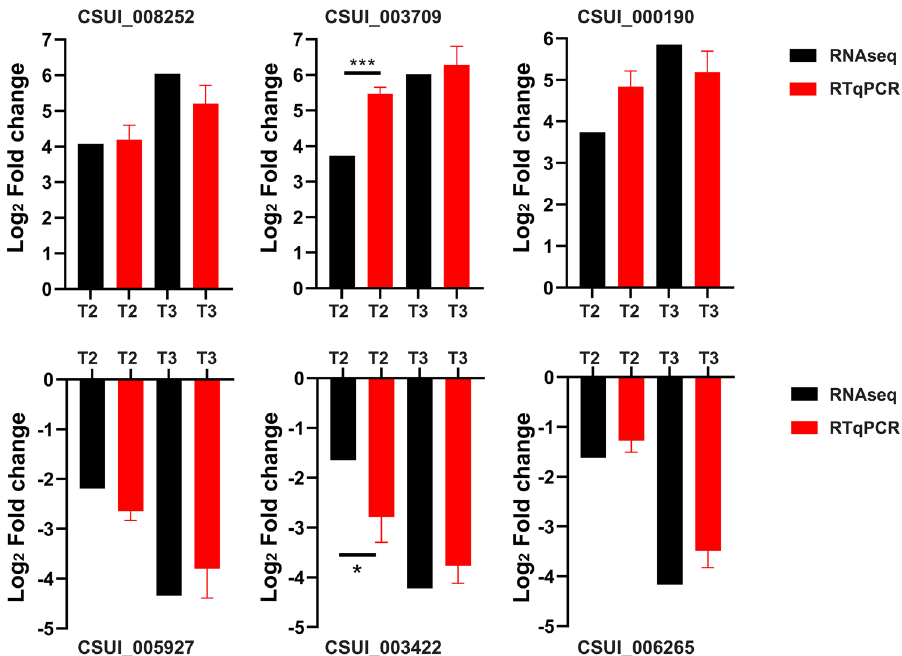
Figure 2. Verification of the gene expression profiles by qRT-PCR. Six genes were selected randomly for validation of the RNA-seq data. According to the RNA-seq results, the expression levels of CSUI_008252, CSUI_003709, CSUI_000190 were upregulated at T2 and T3, and the expression levels of CSUI_005927, CSUI_003422 and CSUI_006265 were downregulated at T2 and T3. Glyceraldehyde-3-phosphate and actin were used for normalization. Values represent the mean ± standard deviation (SD). Asterisks represent significant difference (* P < 0.05, ** P < 0.01***, P < 0.001, **** P <